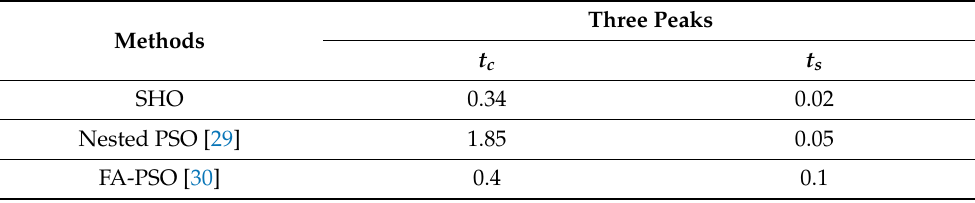
Table 4. Comparative results of SHO, nested PSO, and FA-PSO algorithms for three peaks.